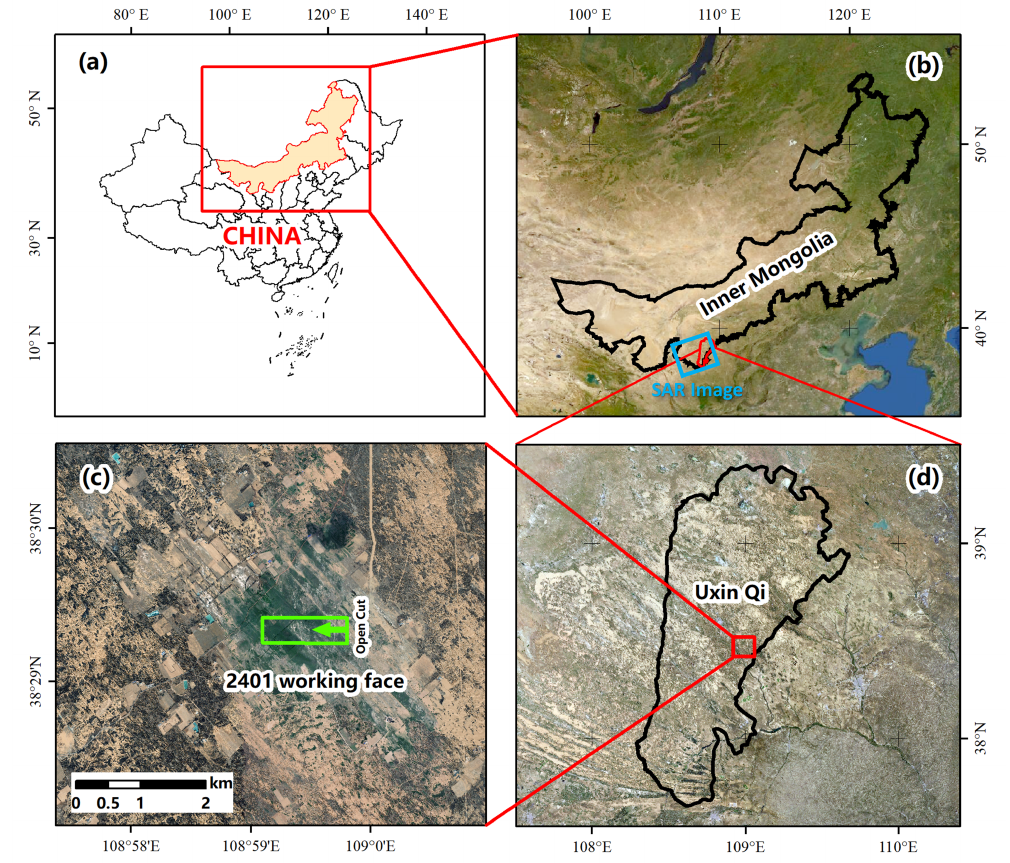
Figure 1. Location of the study area. ( a ) Position at the national level in China. ( b ) Position in Inner Mongolia Province. Blue rectangular frame is the cover range of SAR Images. ( c ) Position in Uxin Qi. ( d ) 2401 working face layout. The direction indicated by the green arrow is the advancing direction of the working